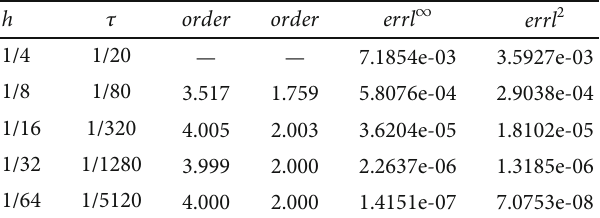
Table 1: Error and convergence order of compact di ff erence scheme.